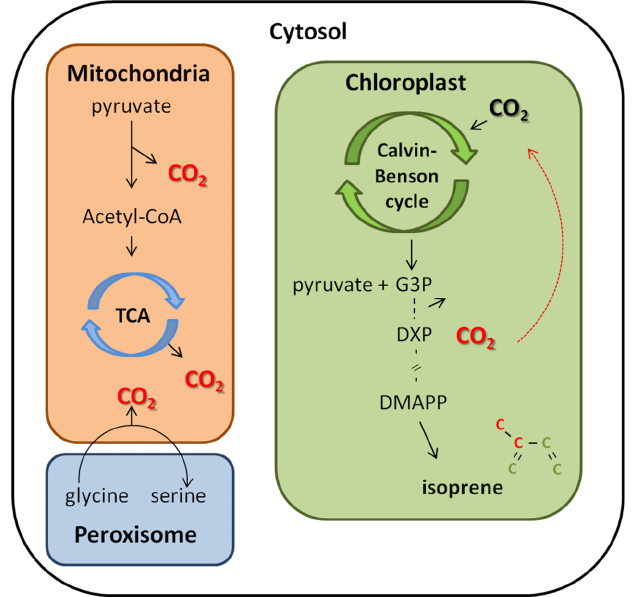
Figure 8. Simplified scheme of the main decarboxylation processes that may contribute as alternative sources for isoprene synthesis: respiration, photorespiration, and the first reaction of the DOXP / MEP pathway.